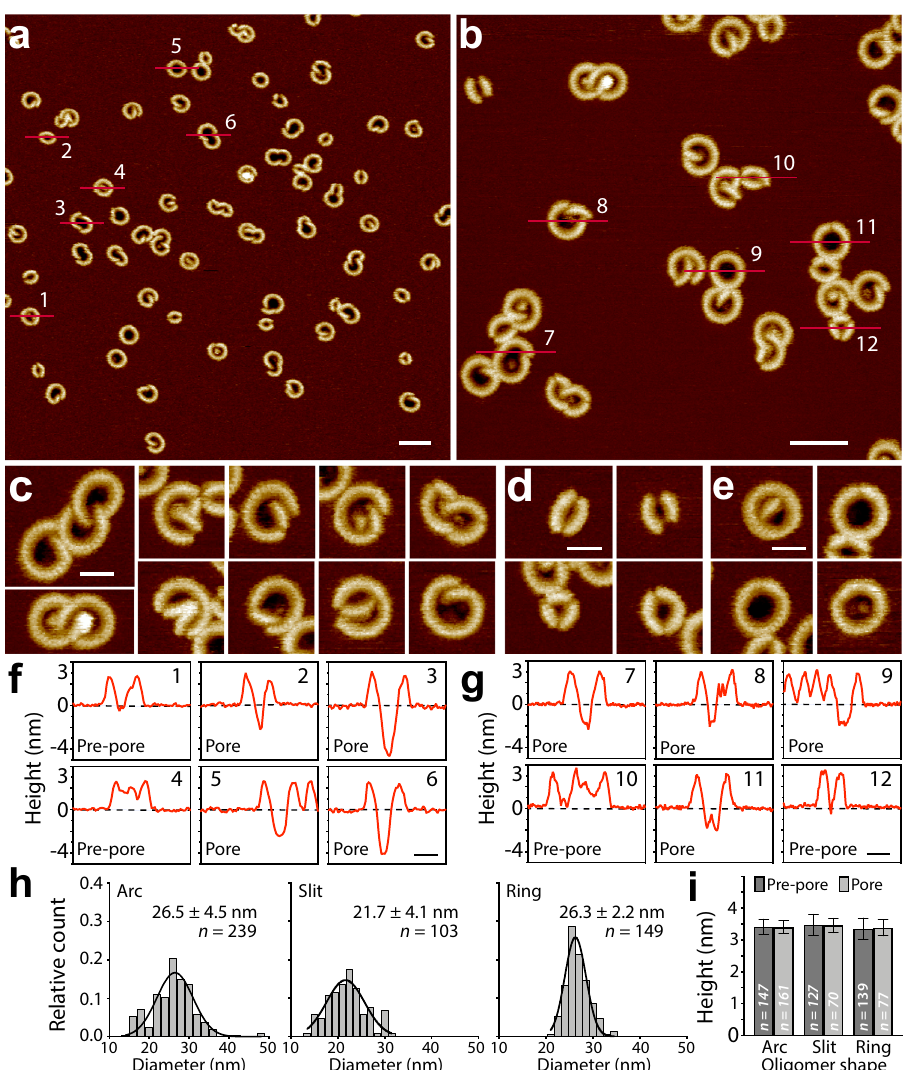
Fig. 1 Murine GSDMA3 Nterm assembles a variety of oligomeric shapes and sizes, which can adopt either the pre-pore or pore state, in lipid membranes. a , b AFM topographs of mGSDMA3 Nterm oligomers formed on supported lipid membranes (SLMs) made from E. coli polar lipid extract. a – e , AFM topographs showing ( c ) arc-, ( d ) slit-, and ( e ) ring-shaped mGSDMA3 Nterm oligomers. f , g Height pro fi les of mGSDMA3 Nterm oligomers measured along the red lines indicated in the AFM topographs ( a , b ). Numbers in the upper right corner correlate height pro fi les to red lines in topographs. Black dashed lines represent the membrane surface (0 nm height). Pre-pore and pore states are indicated for each oligomer. Pore state has been de fi ned for oligomers, whose pores protrude ≥ 2 nm into the lipid membrane. The FD-based AFM topographs were recorded in imaging buffer solution and exhibit a full-range color scale corresponding to a vertical scale of 6 nm. Scale bars, 50 nm ( a , b ) and 20 nm ( c – g ). h , Diameters of maximum height of arc-, slit- and ring-shaped mGSDMA3 Nterm oligomers imaged by AFM in membranes made from E. coli polar lipid extract. Black curves represent Gaussian fi ts determining the mean ± SD values given. i Maximum heights of arc-, slit- and ring-shaped mGSDMA3 Nterm oligomers protruding from the lipid membrane surface and either residing in the pre-pore or pore state. Values present mean ± SD and are given in Supplementary Table 1. n gives the number of oligomers